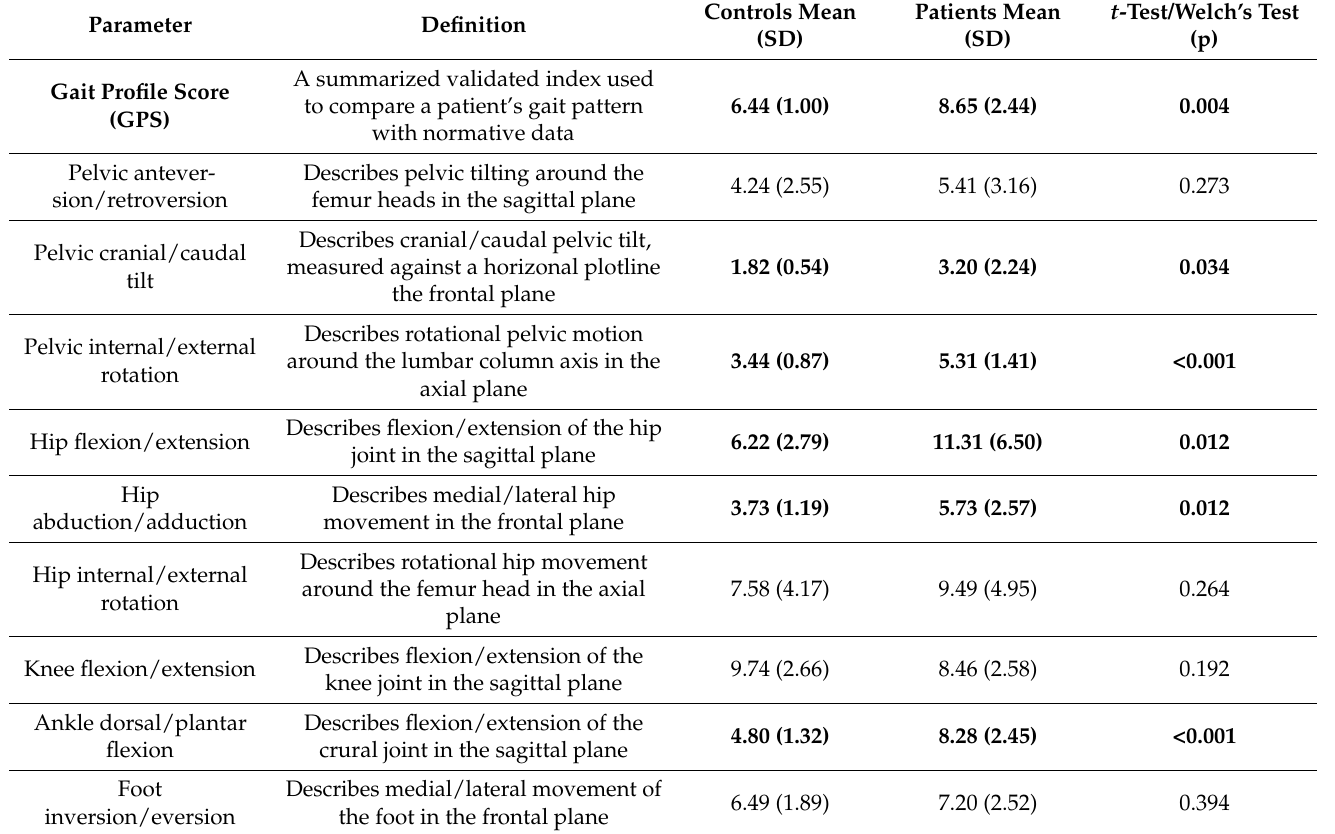
Table 3. Kinematic angular gait parameters of both limbs.